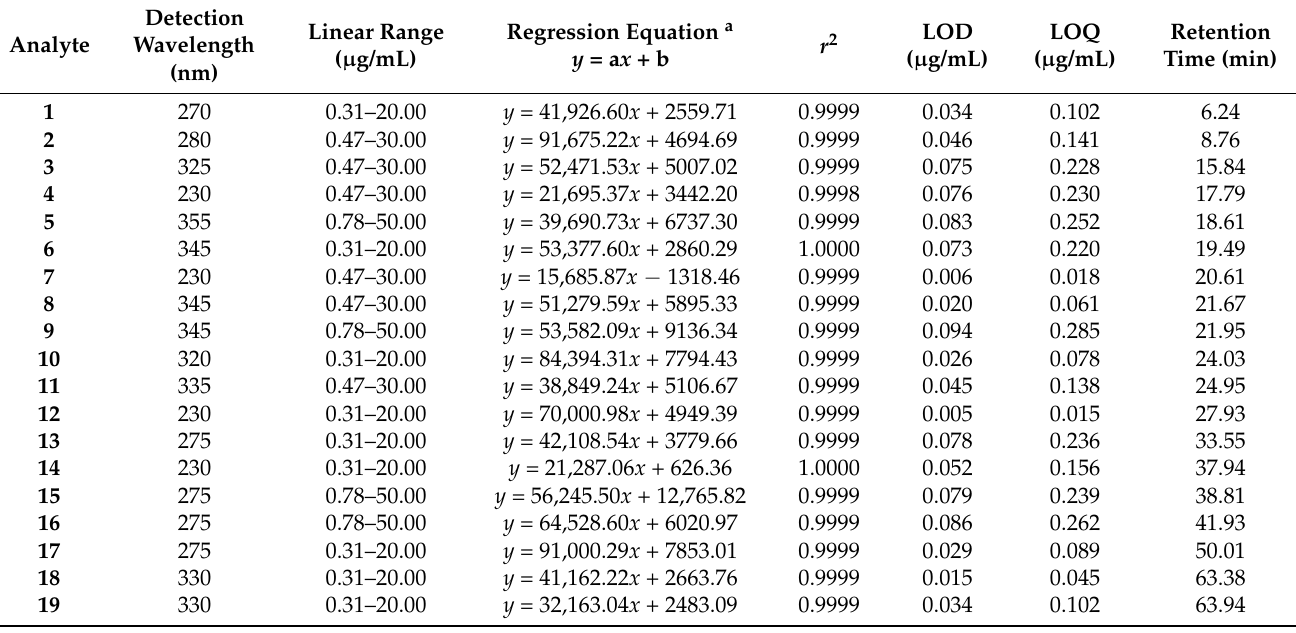
Table 1. Detection wavelength, linear range, regression equation, r 2 , LOD, LOQ, and retention time for simultaneous analysis of each marker component ( n = 3).